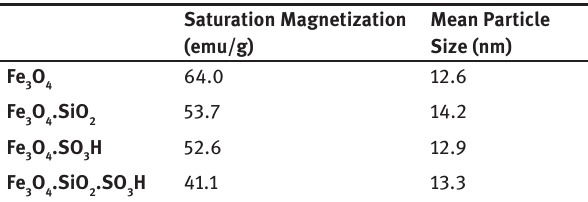
Fi gur e 4: M- H hys t eres i s cur v es for t he F e and 1000 Oe i nse t